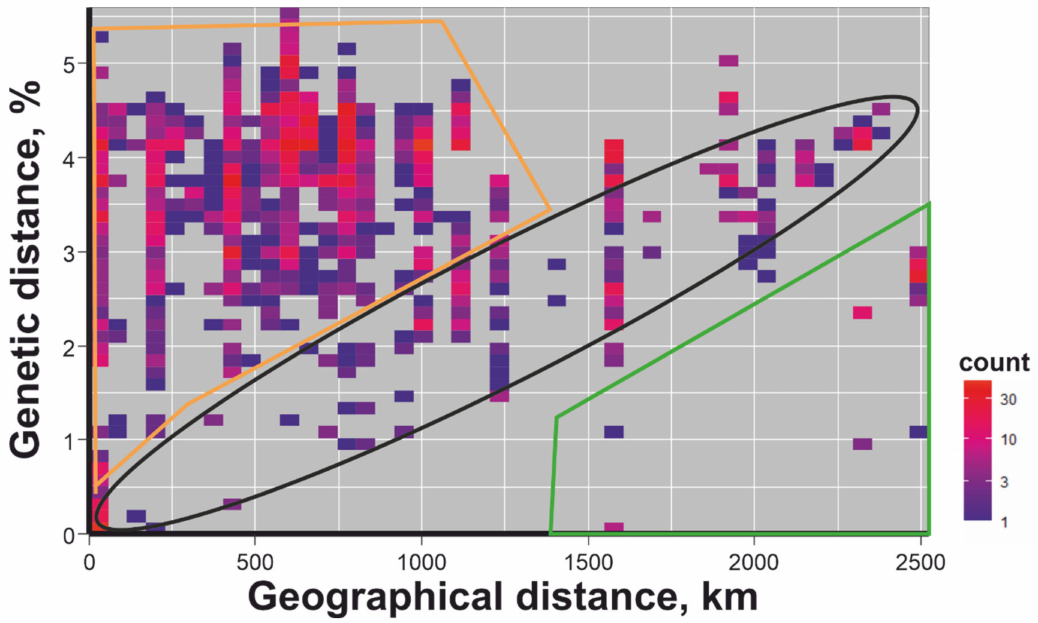
Figure 4. Heatmap of concordance between genetic and geographical pairwise distances for Baltic TBEV. Colour lines indicate suggestive virus spread events discussed in the